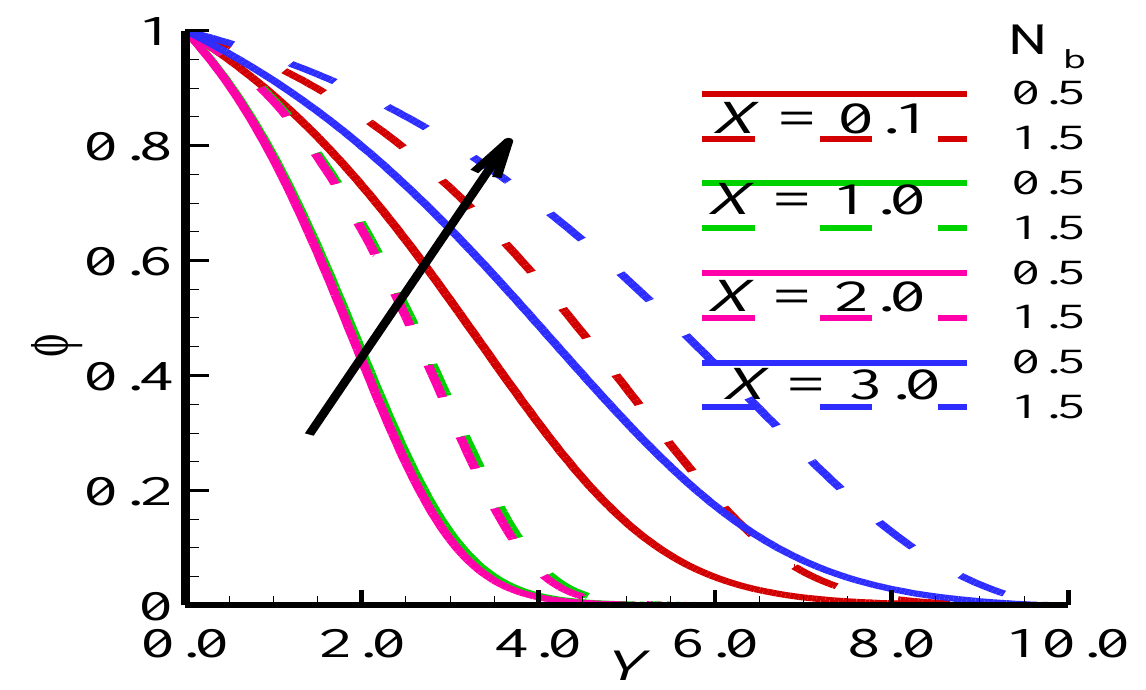
Figure 10. Outcomes of Brownian motion parameter N b on mass concentration φ when N = 0.5, Pr = 7.0, Nt = 1.5, and Sc = 10.0.